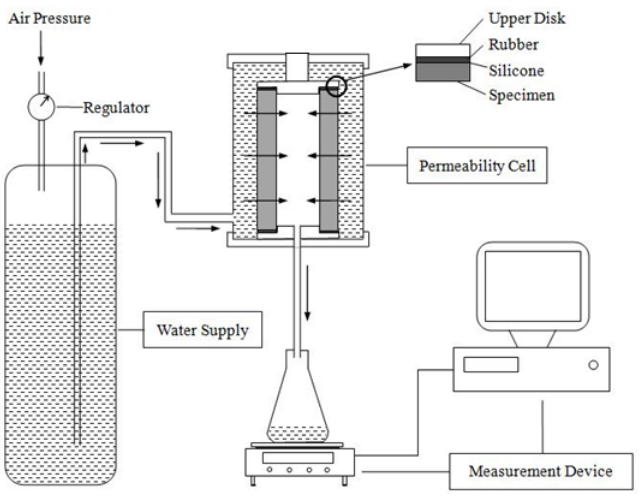
Figure 3. Setup for water permeability test.